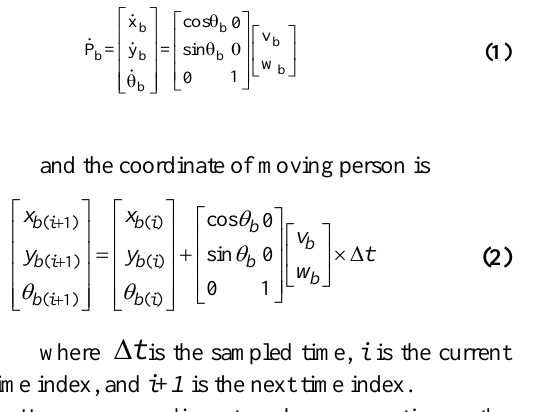
Fig. 4. Different cases between obstacles and